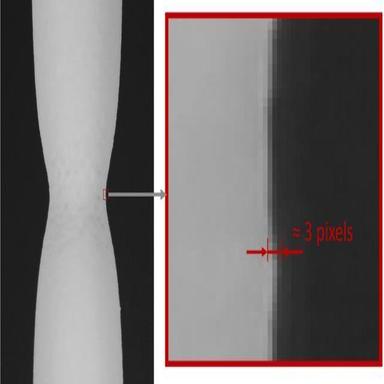
Representation of the accuracy of the neck monitoring technique, thickness of the grey transition between dark and light pixels of the image.